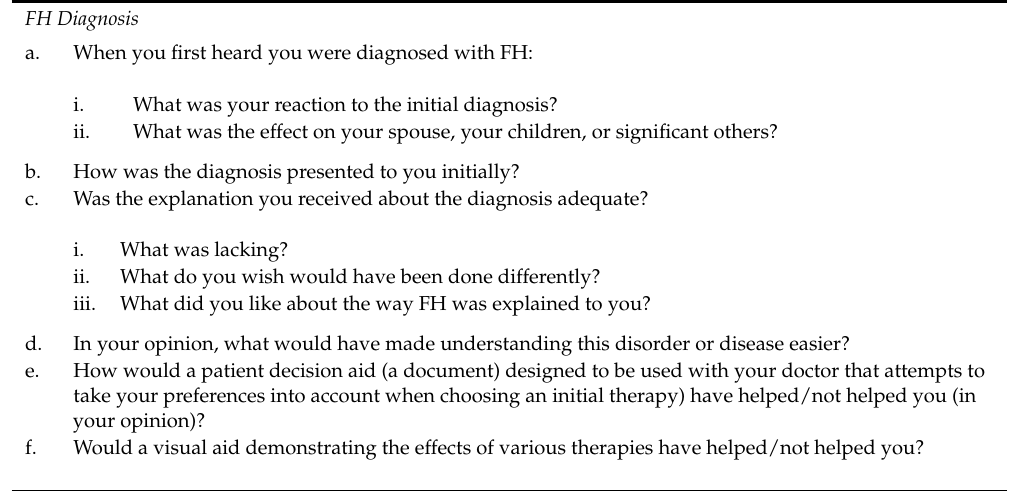
Table 2. Sample questions from focus group discussions with